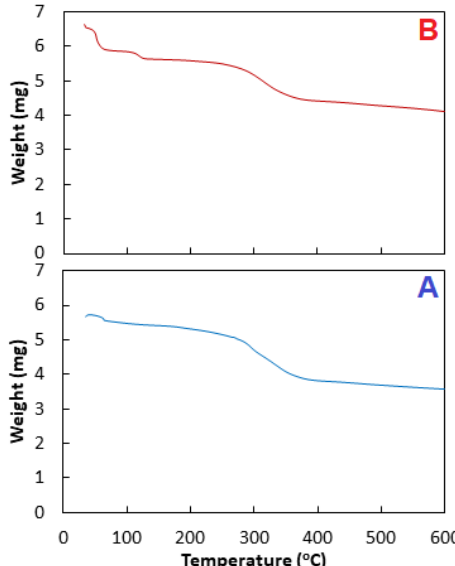
Figure 2: Thermal gravimetric analyses of prepared particles (a) Co O and (b) Ag-Co 3 4